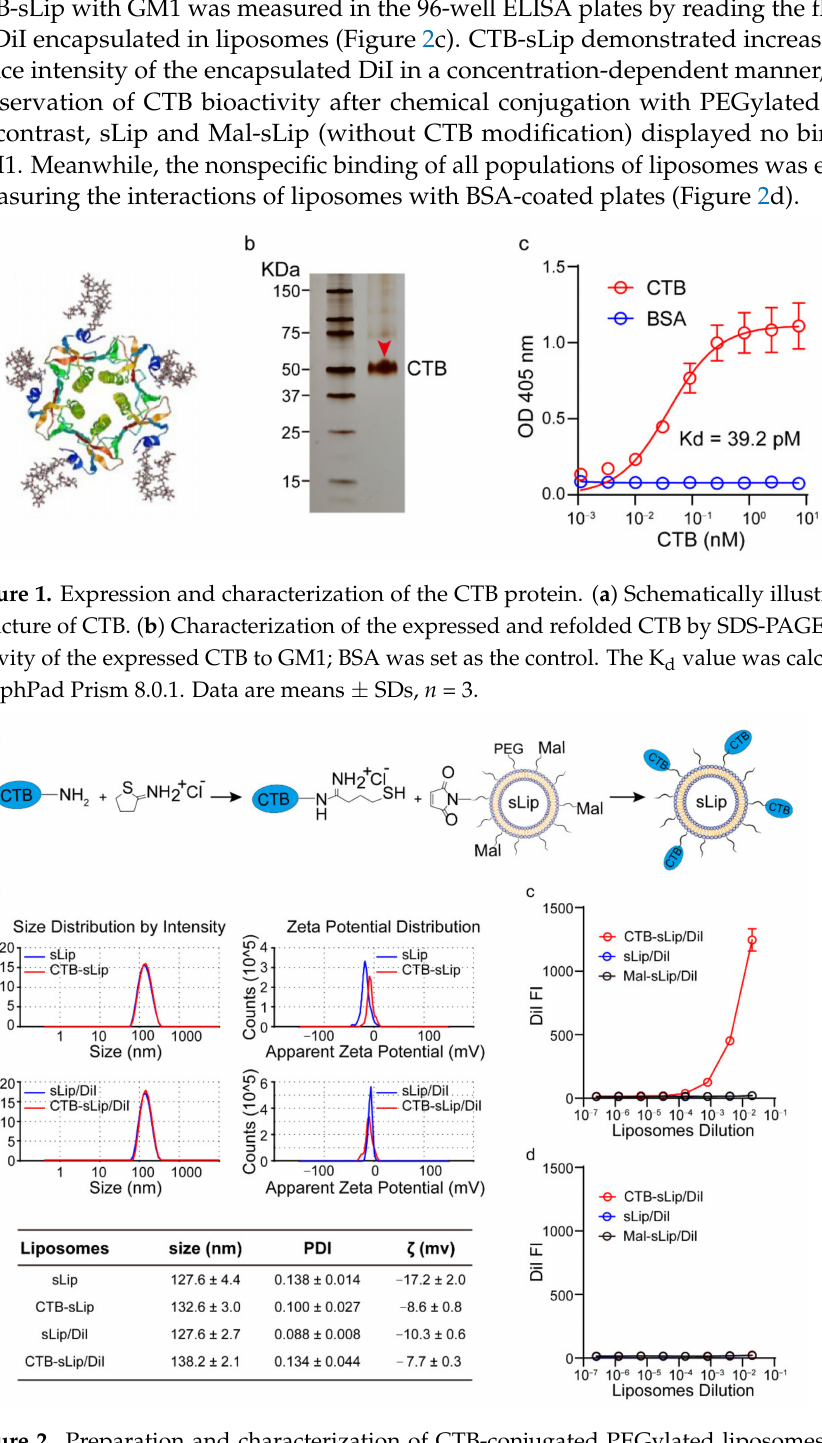
Figure 2. Preparation and characterization of CTB-conjugated PEGylated liposomes (CTB-sLip). ( a ) Schematic illustration of the conjugation method of CTB to the maleimide group grafted on the surface of PEGylated liposomes. ( b ) Size and zeta potential characterization of the prepared CTB-sLip and fluorescence dye DiI-loaded CTB-sLip. The binding activities of CTB-sLip/DiI to GM1 coated ( c ) and BSA coated ( d ) were performed by ELISA; sLip/DiI and Mal-sLip/DiI were set as the controls. Data are means ± SDs, n =